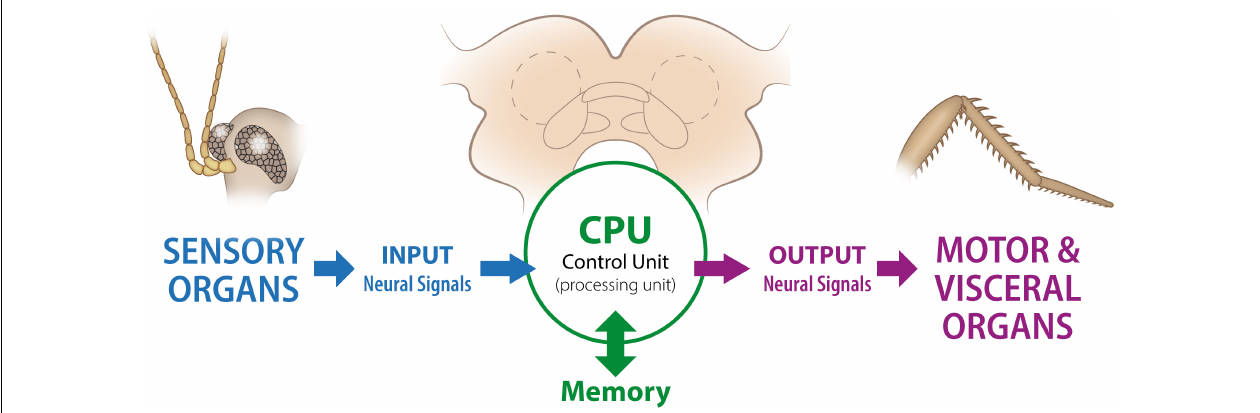
FIGURE 2 | Schematic representation of the “brain as a computer” concept. This diagram is based on the so-called “von Newman architecture scheme”, which was originally proposed as a representation of a digital computer. While in the original formulation the “Processing” (with processor registers) and “Control” (with instruction registers) units were considered as independent components, for simplicity we have included both under the general name “Processing Unit.” In most centralized nervous systems, the memory storage is also part of the anatomical structure holding the central computing unit (in the brain). In the diagram we show, in a very simplified way, the parallels between biological and computer structures. As an illustrative example we use a brain plus sensory and motor organs from a